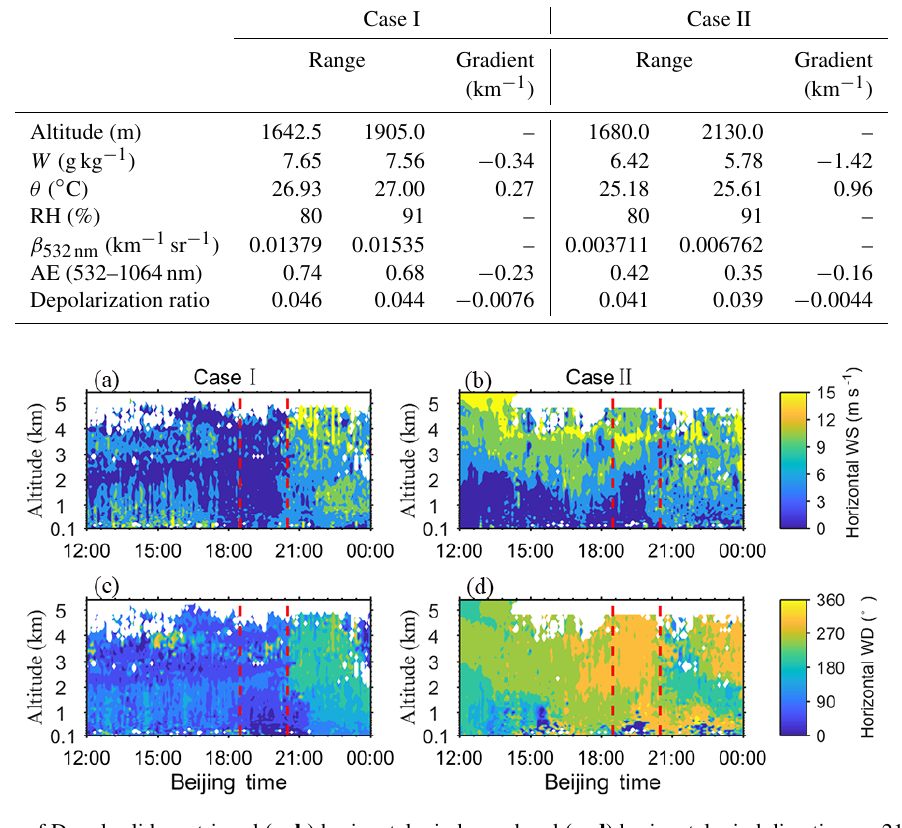
In other words, there is no change in the aerosol type of both cases within the region of